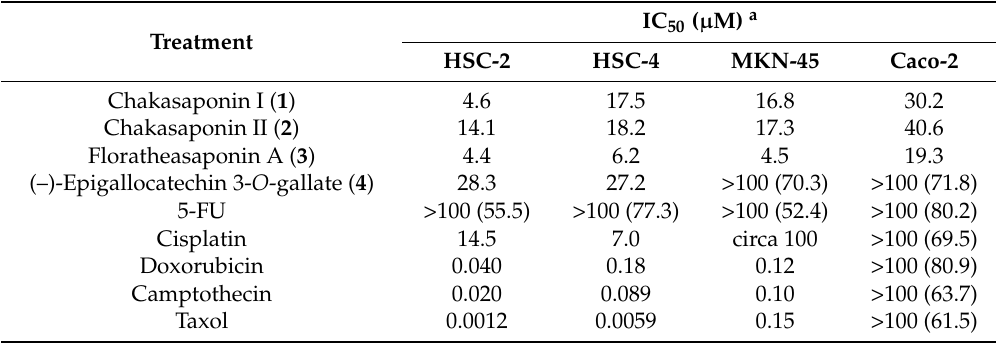
Table 1. Antiproliferative effects of compounds 1 – 4 from “tea flower” on human digestive